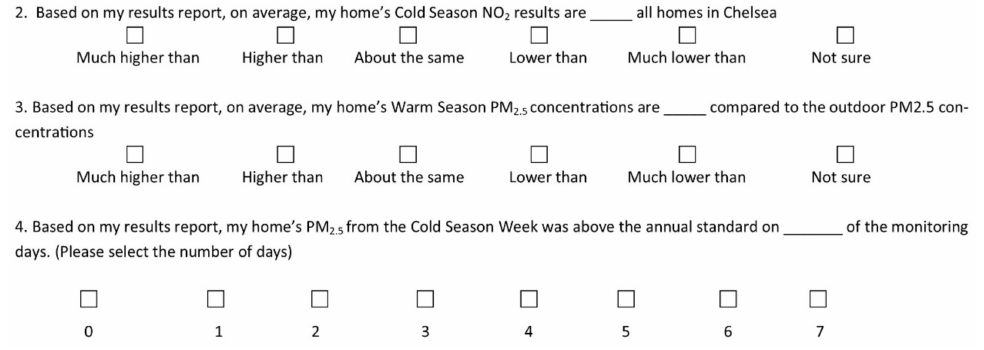
Figure 2. Visual of the data comprehension questions asked of the